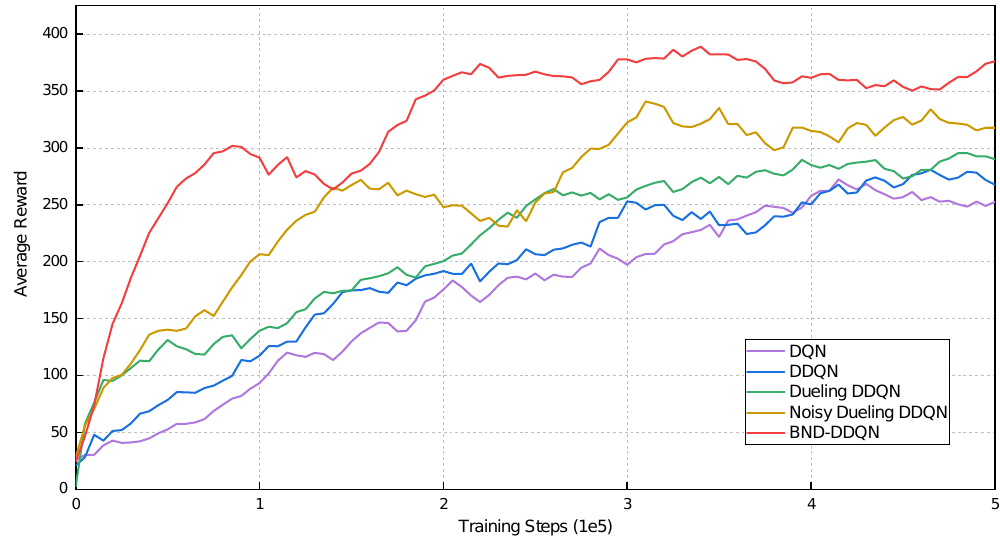
Figure 4. Average total rewards received by various models at different training steps in the first virtual environment. Compared to baseline methods, the BND-DDQN model results in the highest average reward as well as the fastest convergence